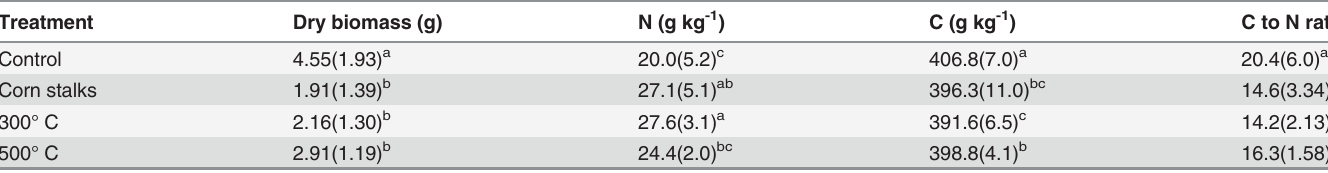
Table 3. Mean proso millet biomass, tissue C, tissue N, and C to N ratio at harvest.